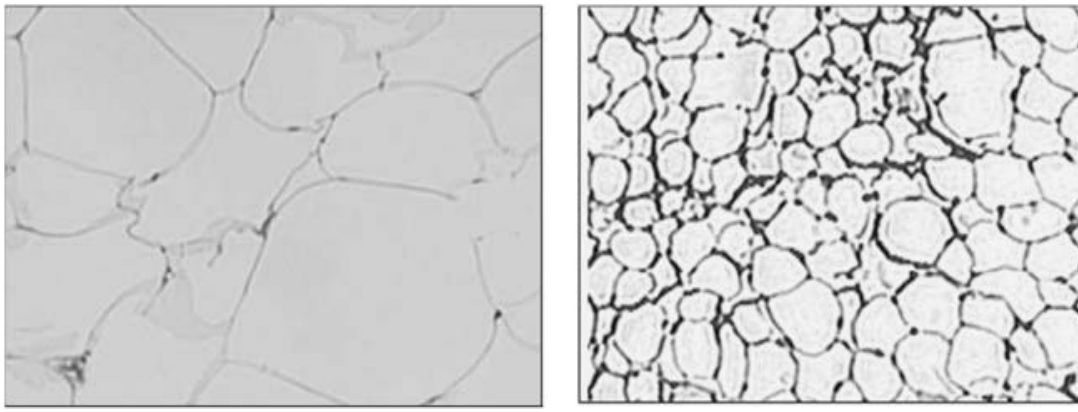
Figure 1. Comparative pictures of enlarged adipocytes from South Asian (left) and White (right) volunteers. Both images are obtained with SPOT digital camera using 10 magnification. Note: this figure is reproduced with permission from [74]. Copyright Chandalia et al. ,